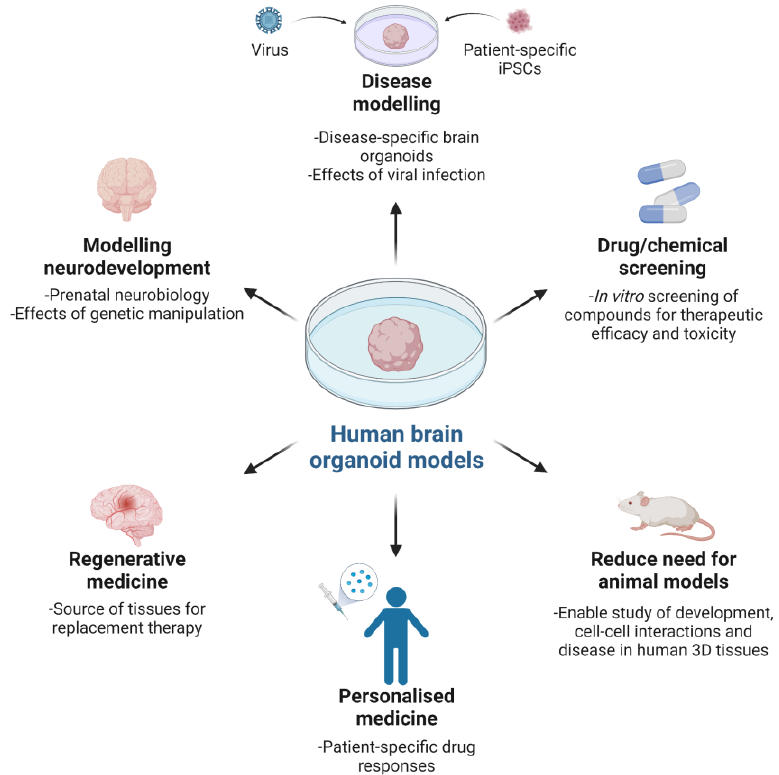
Figure 2. The value and utility of human brain organoid models.